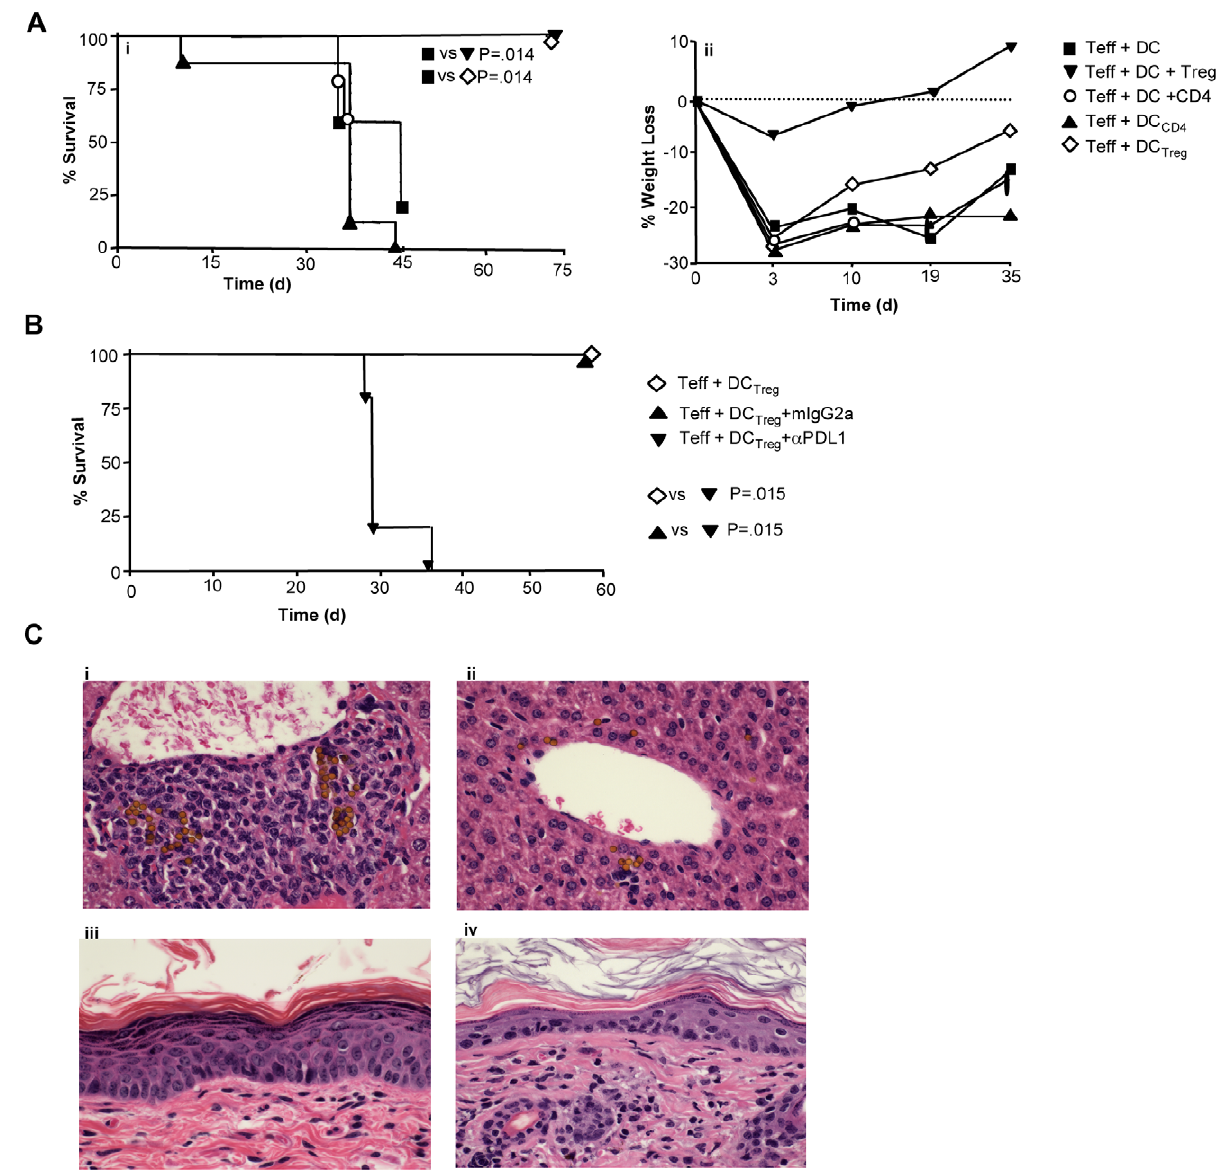
Figure 5. Tregs or Treg-conditioned DC protect against lethal xenogeneic GVHD. Using Rag2 2 / 2 c c 2 / 2 mice as host, transplant cohorts received effector T cells (‘‘T eff ’’) in combination with allogeneic DC, control CD4 cell-conditioned DC (‘‘DC CD4 ’’), or Treg-conditioned DC (‘‘DC Treg ’’); other cohorts received Teff cells in combination with allogeneic DC plus either Tregs (‘‘Treg’’) or control CD4 cells (‘‘CD4’’). The doses of the Teff, DC, and Treg cells were 3 6 10 7 , 3.0 6 10 6 , and 1.5 6 10 6 cells per recipient, respectively. (A) Overall survival is shown in (i); posttransplant weight loss is shown in (ii). (B) In an independent experiment, transplants were performed at these same cell doses, and posttransplant survival was determined. Treg-conditioned DC were incubated with anti–PD-L1 (‘‘ a PDL1’’) or isotype control antibody (‘‘mIgG2a’’) for 30 min prior to adoptive transfer; in addition, anti–PD-L1 or isotype control antibody was injected i.p. immediately after cell transfer (100 m g/mouse). (C) Representative result of histology analysis performed at day 30 posttransplant demonstrates T cell infiltration of liver in the GVHD control group (i) and minimal infiltration in recipients of Tregs (ii). Representative histology of skin demonstrates cutaneous acanthosis and hyperkeratosis in GVHD controls (iii) and minimal skin pathology in recipients of Tregs (iv). doi:10.1371/journal.pbio.1000302.g005 dynabeads (bead:cell ratio, 4:1), incubated (30 min, 4 u C), separated (hand-held magnet, Dynal); and (3) CD127-depleted cells were subjected to CD4 cell isolation by microbeads. Ex Vivo Culture of Total CD4 + and CD4 + CD127 2 T Cell Subsets Total CD4 + and CD4 + CD127 2 T cells were cultured in polystyrene tissue culture flasks (Corning). Cells were activated